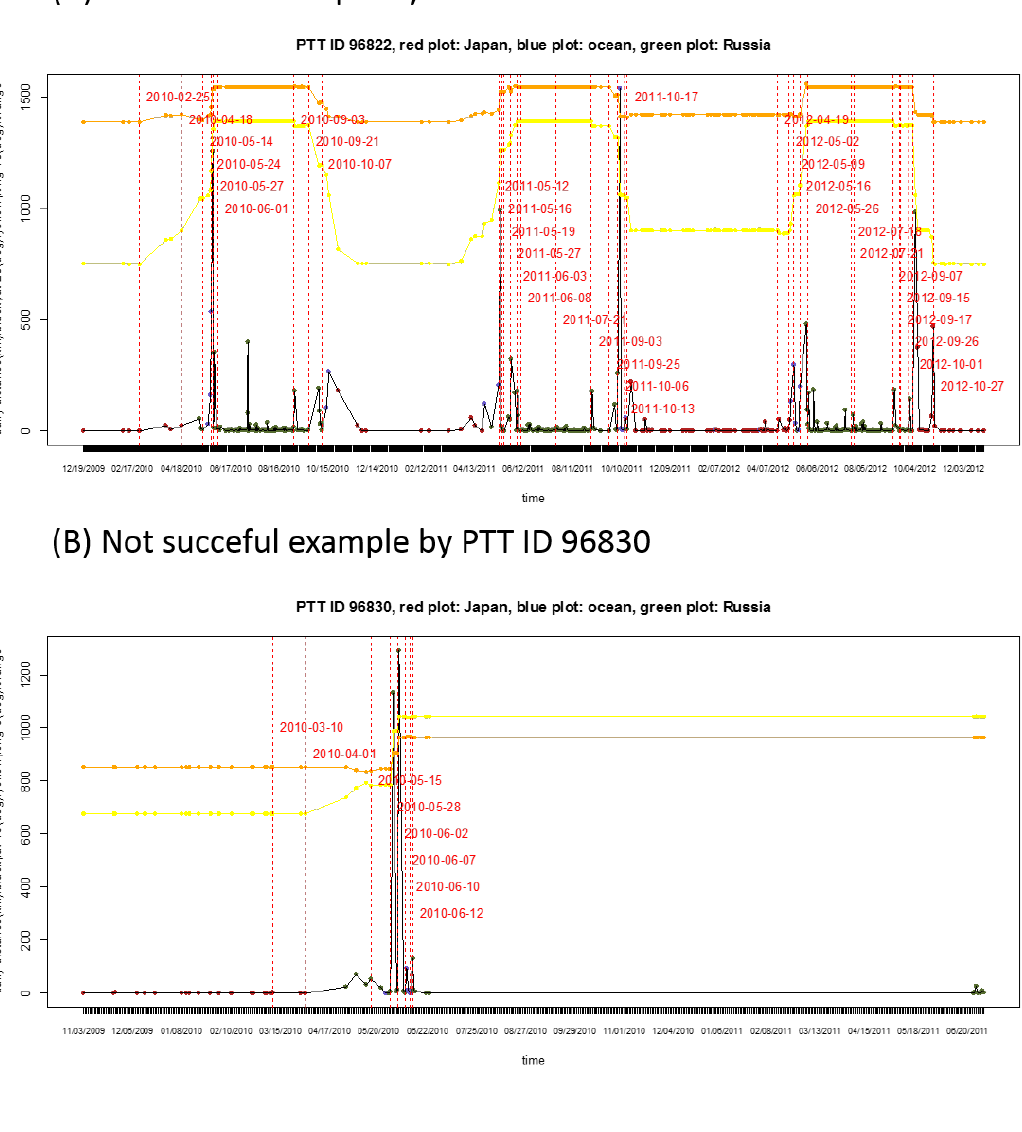
Figure 7. Examples of visualization